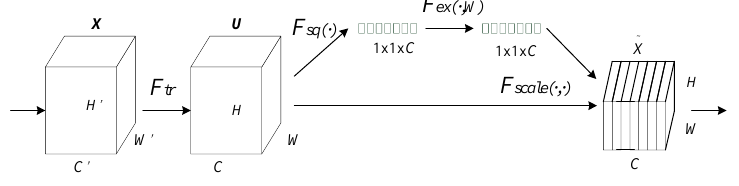
Figure 5. SE module